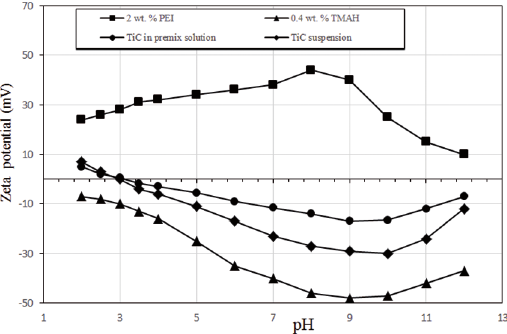
Figure 4: Zeta potential of TiC suspention without dispersant and TiC in the premix solution with and without dispersant. isoelectric point (IEP) of TiC powders is at pH 3.1. The TiO 2 surface oxide in the presence of water easily hydrolysed to Ti-OH groups. When the pH is lower than the IEP, Ti–OH reacts with H + leaving Ti–OH + with positive zeta potentials. 2